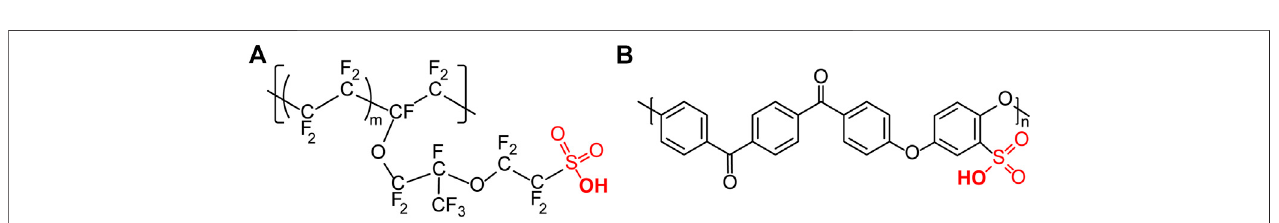
FIGURE 4 | Chemical structure of Na fi on (EW 1100), m (cid:2) 6.5 (Mauritz and Moore, 2004) and sulfonated polyetherketone (SPEEK) (Klemm et al., 2005).